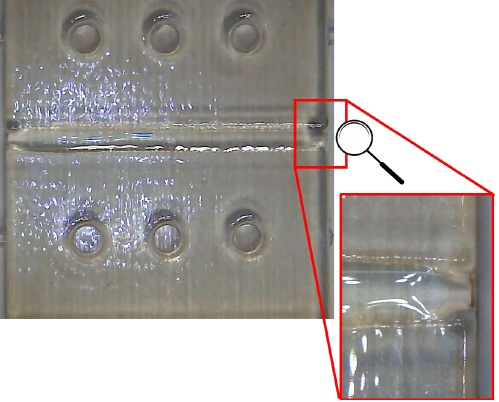
Figure 9. Digital microscope images acquired at variable magnifications (ranging from 50 × to 1000 ×